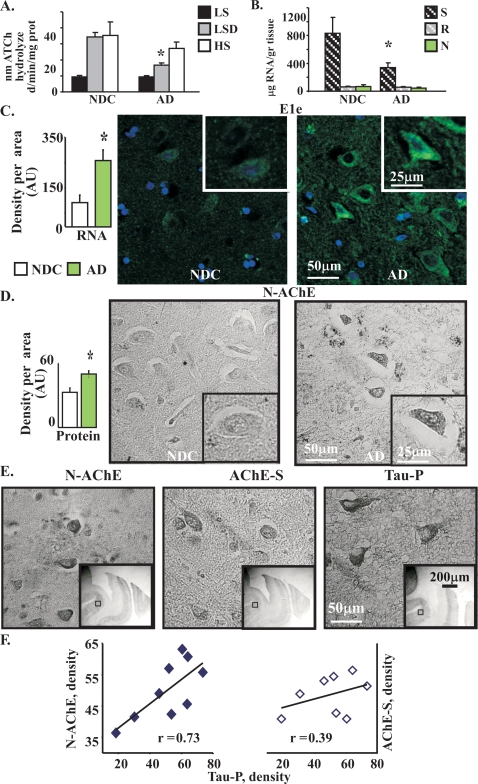
N-AChE-S overexpression in AD cortical neurons associates with Tau hyper-phosphorylation.A. Differential fractionation of AChE hydrolytic activity. Cortical protein was fractionated into low salt (LS, soluble protein), low salt detergent (LSD, membrane-associated) and high salt (HS, integral membrane and nuclear proteins) and AChE activity was measured. Note decrease in LSD (AChE-S-enriched) fraction, but not LS or HS fractions (p = 0.0476, n = 4 NDC, 8AD, Median test). B. AD-associated changes in AChE mRNA transcripts. Columns: QRT-PCR. Note AD-associated decrease as compared to NDC samples in the S, but not the N or R encoding exons. (p = 0.055, n = 10 AD, 5 NDC Wilcoxon Two Sample Test). C. Inset is: E1e labeling of post mortem sections from human entorhinal cortex. Columns are quantification of labeling density per area. (Median test, *p = 0.0286, n = 4 in each group). D. N-AChE-S Immunostaining in AD and NDC cortices. Columns are quantification of density per area (*p = 0.029 n = 5 NDC, 9AD Median Test). E. AD Entorhinal cortices immunolabeled for N-AChE, AChE-S or hyper-phosphorylated Tau-P. F. N-AChE and AChE-S labeling correlate with Tau-P density. Tau-P, N-AChE, and AChE-S labeling were quantified using immunohistochemistry on sections from the entorhinal cortex of AD patients. (Pearson's correlation for N-AChE and Tau-P, 0.73, p = 0.03).